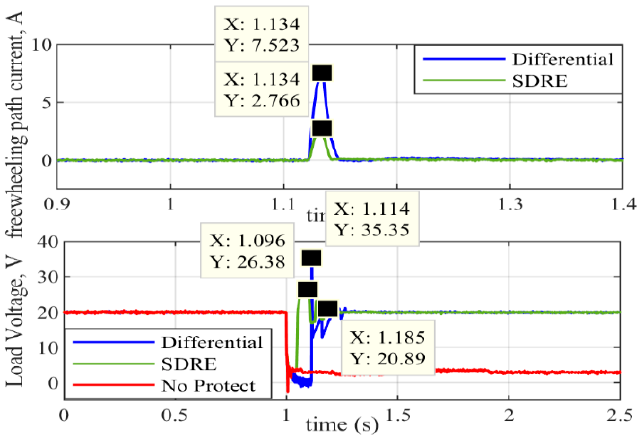
Figure 21. Voltage of resistive load and the current of freewheeling in no protection, differential, and SDRE observer modes.